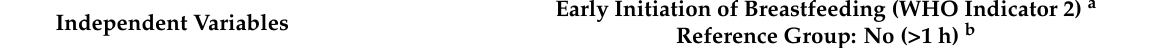
Table 4. Key determinants of selected breastfeeding and child growth indicators among infants under six